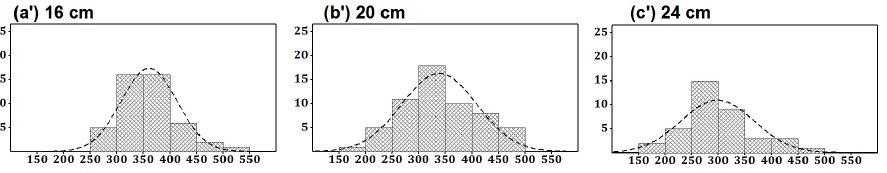
Figure 7. Histogram of nanofibers influencing the collecting distances 16 cm, 20 cm, and 24 cm at a constant voltage of 45 kV and with a constant polymer concentration of 20%.